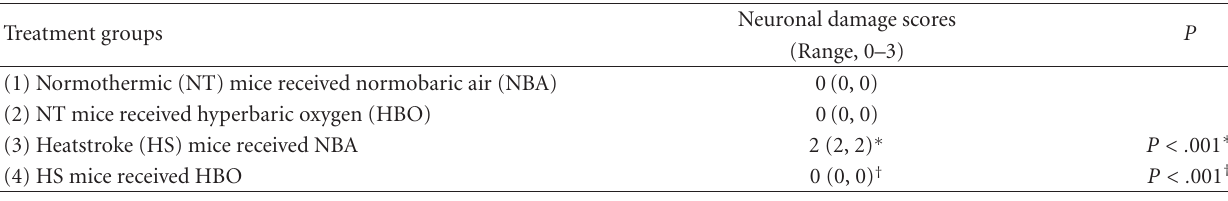
Table 3: Hypothalamic neuronal damage score values for di ff erent groups of mice ( n = 8 per group). Treatment